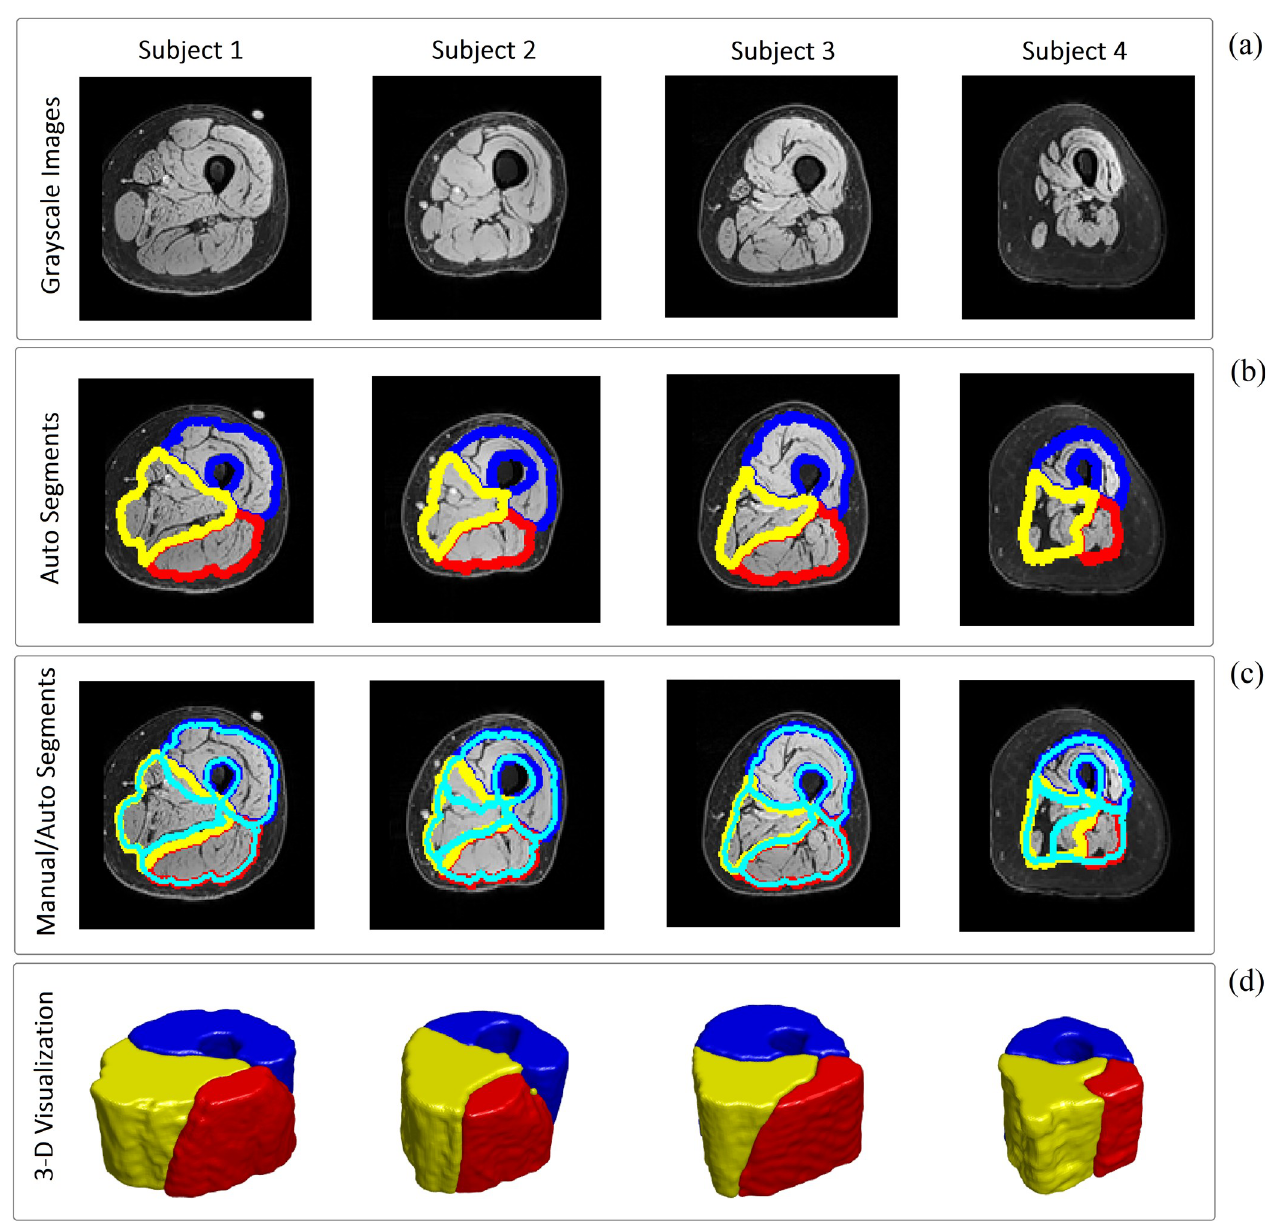
Fig 5. Examples of muscle group segmentation algorithm for four SCI subjects. (a) original cross sectional MR image; (b) automatic segmentation of muscle groups: blue area is extensor, red is flexor and yellow presents the medial compartment; (c) manually segmented muscle groups (cyan lines) overlaid on automatic segmentation for comparison; and (d) 3-D representation of automatic segmentation of muscle groups: blue volume is extensor, red is flexor and yellow presents the medial muscle group.